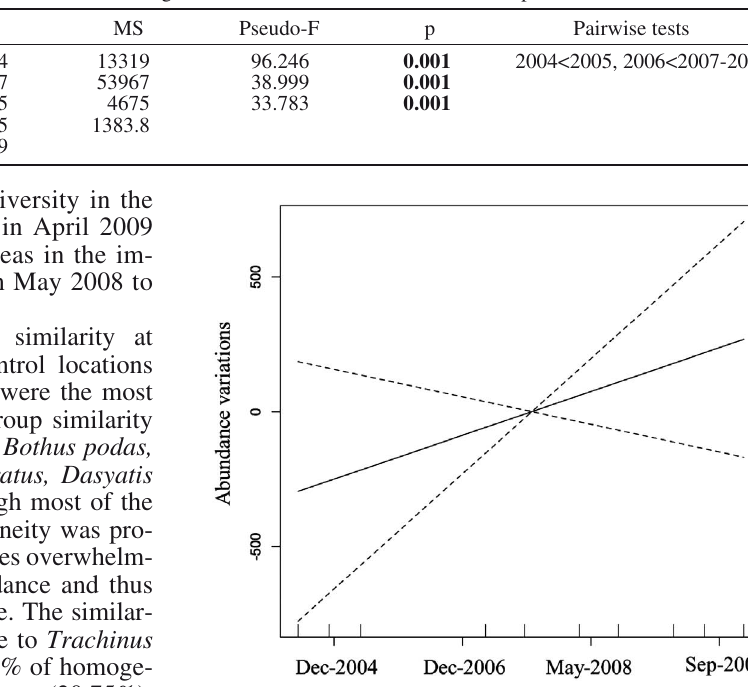
Fig. 3. Temporal trend of Boops boops population modelled by GAM during the study period